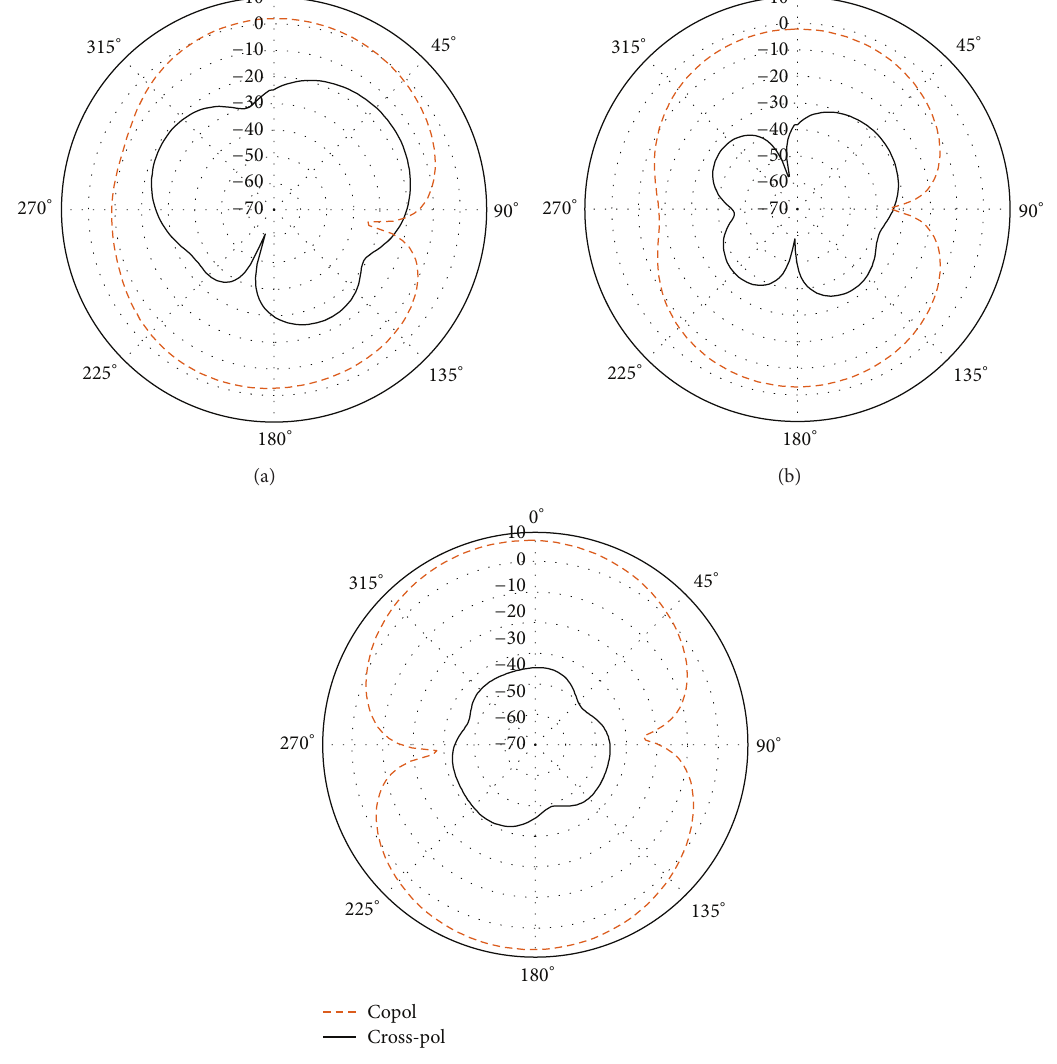
and at 270 ∘ . All the radiation patterns shown are for the E-